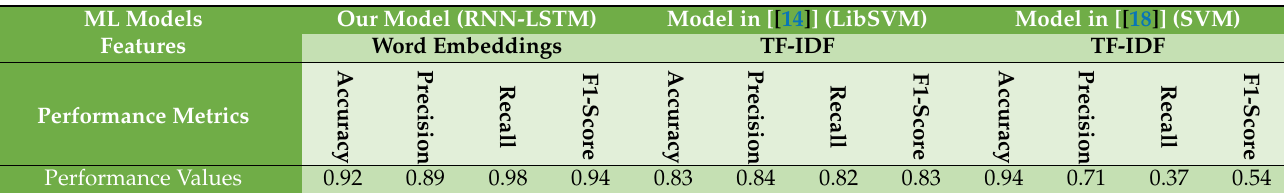
Table 6. Comparison of the model results.